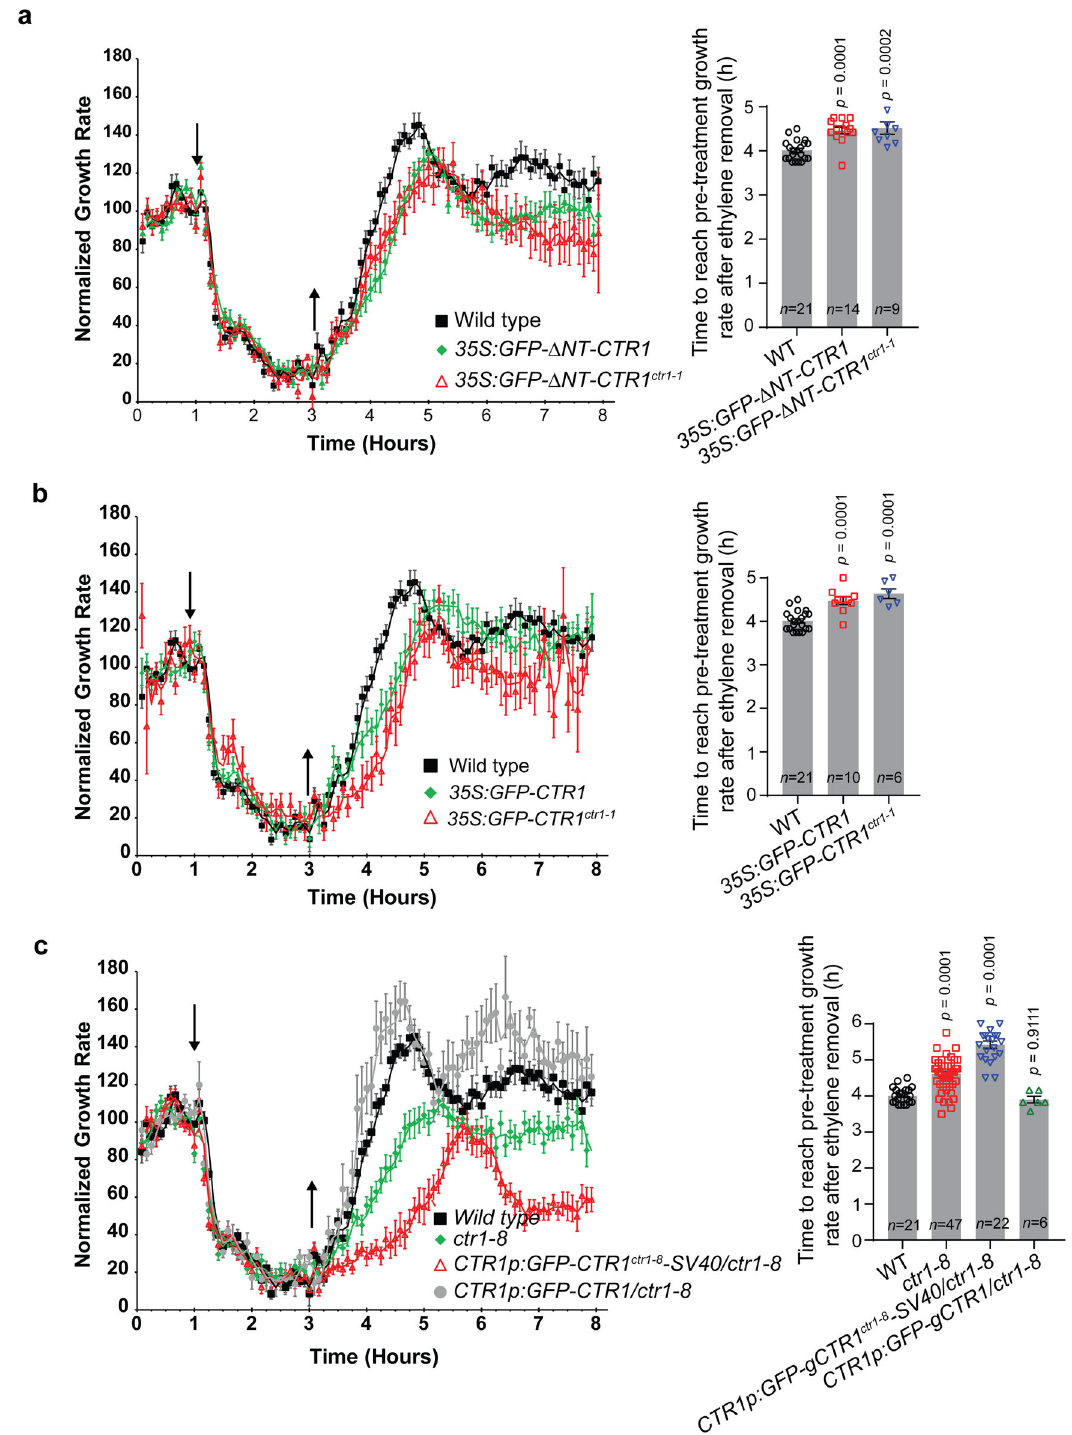
b 35S:GFP-CTR1 and 35:GFP-CTR1 ctr1-1 . c ctr1-8 , CTR1p:GFP-gCTR1 ctr1-8 -SV40/ctr1-8 ,and CTR1p:GFP-gCTR1/ctr1-8 . Data were normalized to the growth rate in air before treatment with ethylene. The experiments were repeated at least twice and gen- erated similar results. The graphs indicate the quanti fi cation of time to reach pre- treatment growth rate after ethylene removal. Error bars, SE, Two-tailed Stu- dent ’ s t